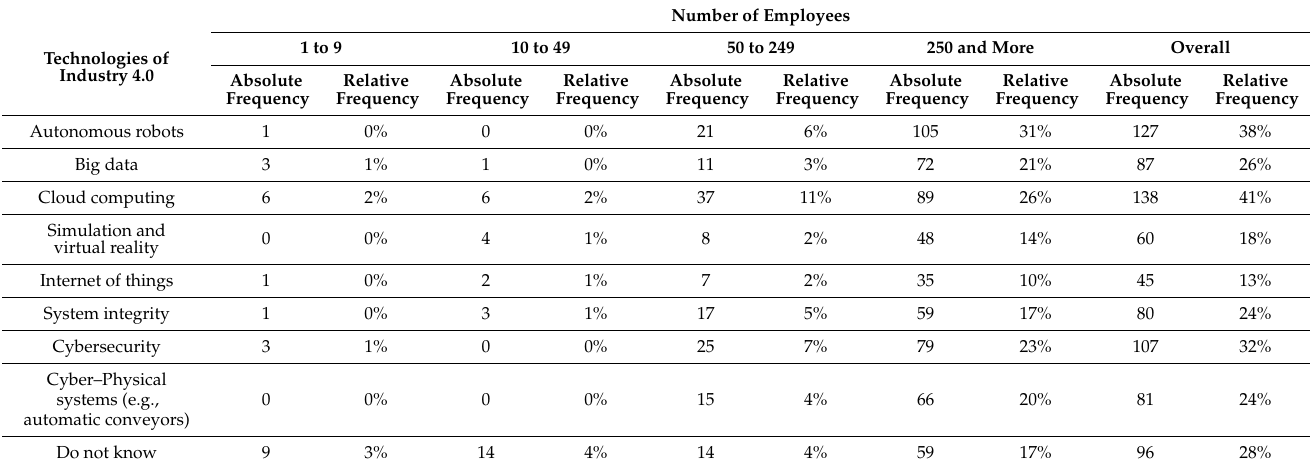
Table 6. Implementation of Industry 4.0 technologies depending on the size of the company.